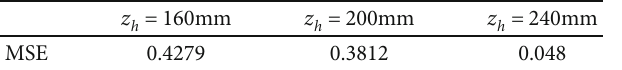
Table 1: Comparison of reconstruction errors at di ff erent recording